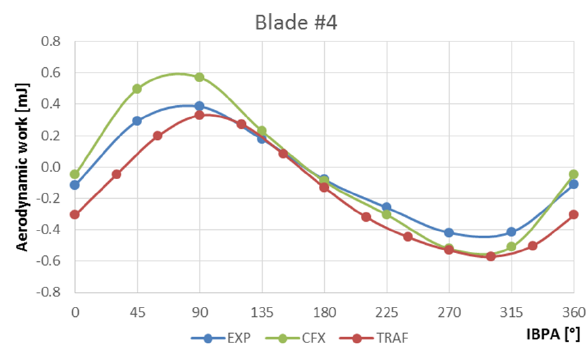
Figure 18. Aerodynamic work of blade bending motion - blade #6: experimental (EXP), CFX and TRAF comparison.